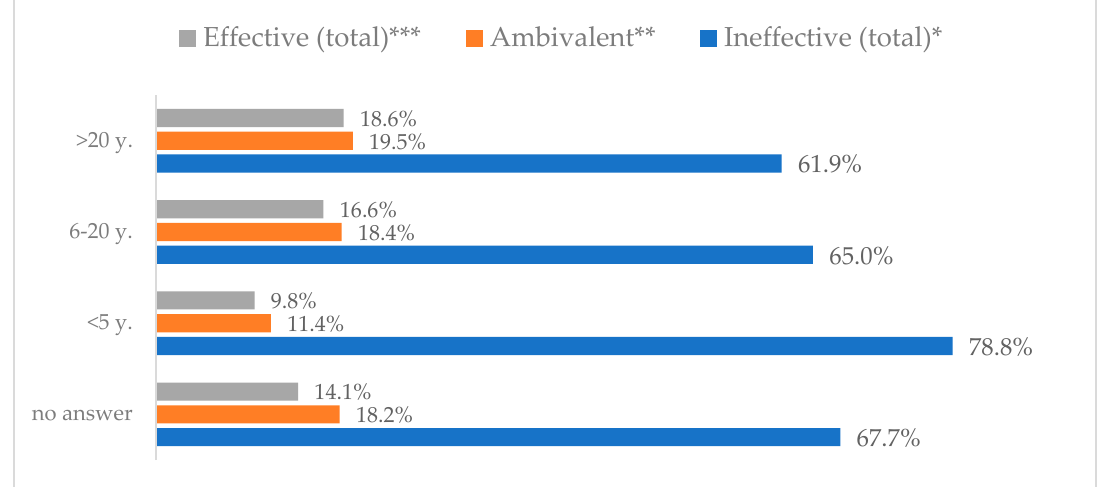
Figure 25. Eating garlic to prevent influenza virus infection by seniority ( N = 905). * Sum of responses: